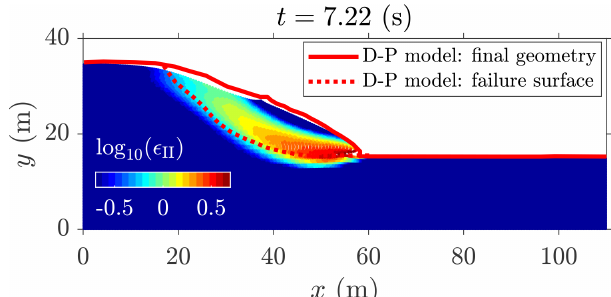
Figure 15. MPM solution to the elasto-plastic slump. The red lines indicate the numerical solution of Huang et al. (2015), and the coloured points indicate the second invariant of the accumulated plastic strain (cid:15) II obtained by the CPDI solver. An intense shear zone progressively develops backwards from the toe of the slope, result- ing in a circular failure mode.